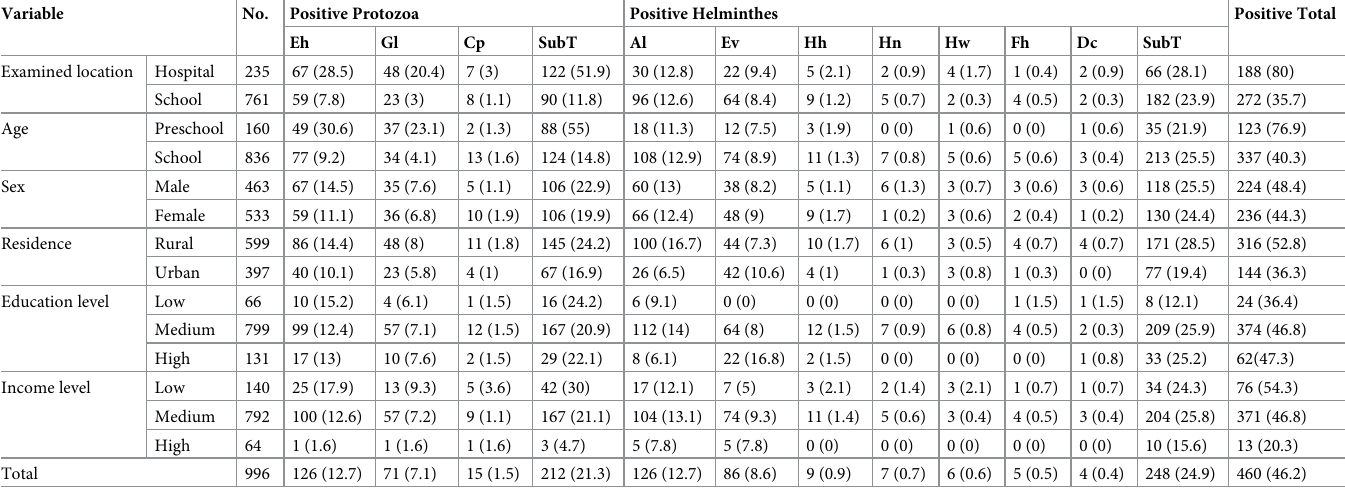
Table 2. Prevalence and socio-demographic characteristics of IPIs in children in Gharbia governorate, Egypt. Variable No. Positive Protozoa